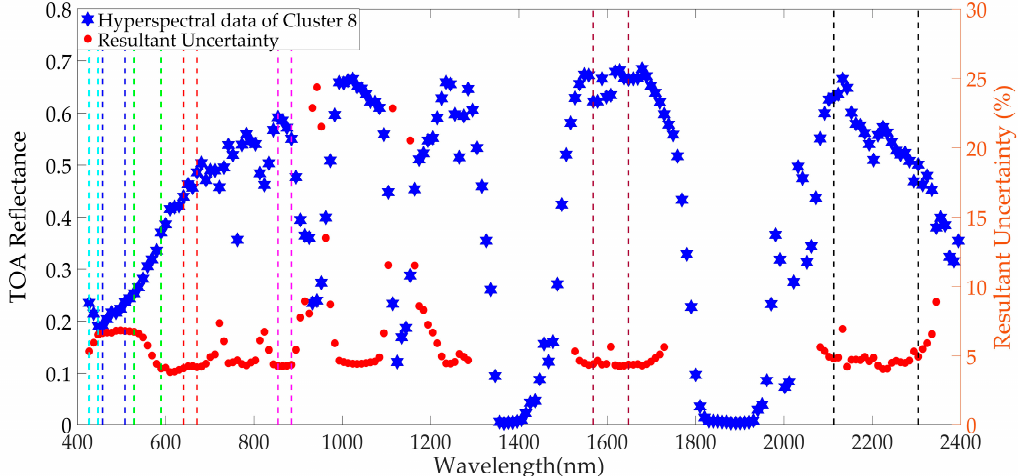
Figure A5. Estimated representative hyperspectral profile of Cluster 7 and its resultant uncertainty.